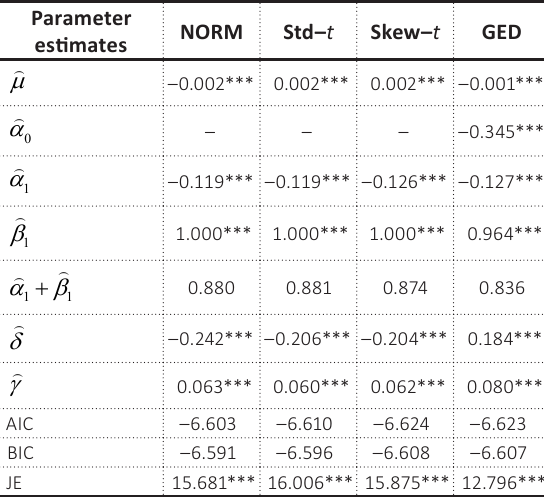
Table 9. ML parameter estimates for EGARCH-M with different innovation distributions